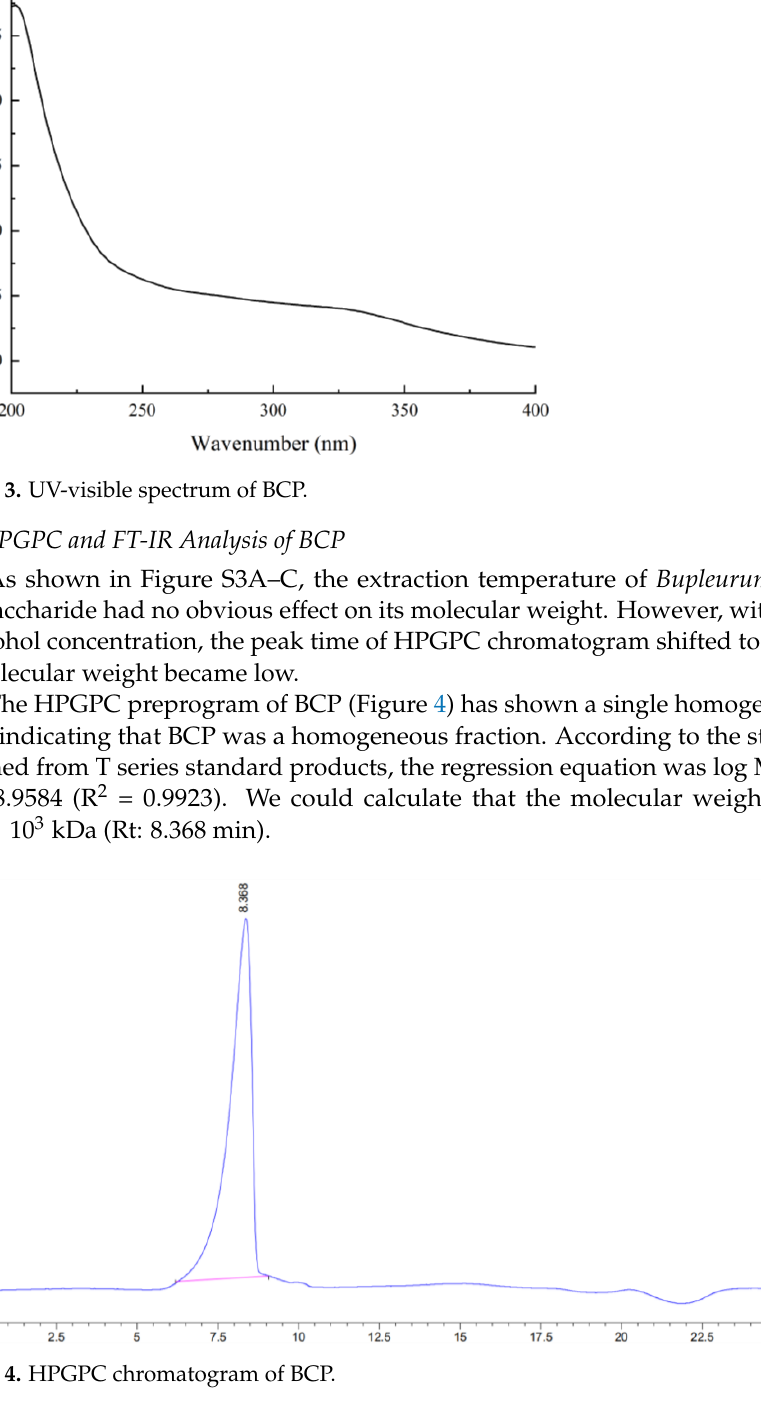
Figure 5. FT-IR spectrum of BCP. 3.3. Monosaccharide Composition Analysis of BCP Figure 6A,B showed the ion chromatograms of monosaccharide standards and BCP hydrolysates. The analysis revealed the major compositions of BCP: rhamnose, arabinose, galactose, glucose, and galacturonic acid, with a molar ratio of 0.063:0.788:0.841:1:0.196. In recent years, researchers have isolated different kinds of polysaccharides from Bupleurum to explore their structure. The monosaccharide compositions of other Bupleurum polysaccharide analogues were compared with BCP, as shown in Table S3 [11,12,15,16,42 – 46]. The detection of galacturonic acid in BCP was consistent with the previous determination of uronic acid in BCP by the carbazole sulfonic acid method [47].